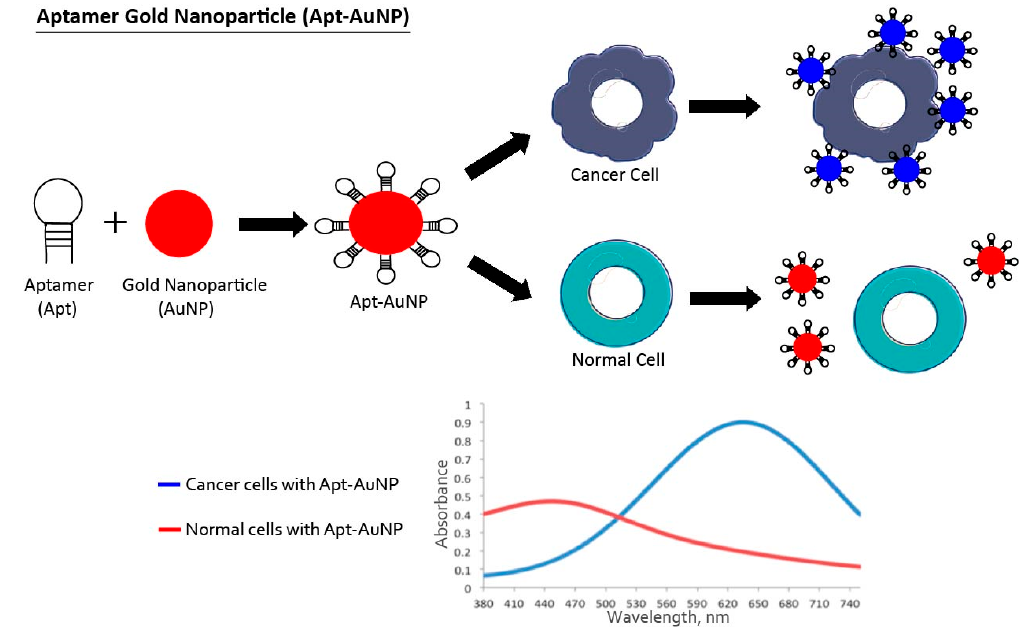
Figure 2. Schematic illustration of aptamer-gold nanoparticle (Apt-AuNP) molecules for cancer cell detection. The aptamer (Apt) linked to gold nanoparticles (AuNP) bind specifically to cancer cells and start to behave as a larger gold structure because of the particle’s proximity. The short proximity to each other causes a shift in the absorption spectra of the particles. However, the Apt-AuNP complex cannot recognize normal cells, which results in no alteration of the absorption signal.